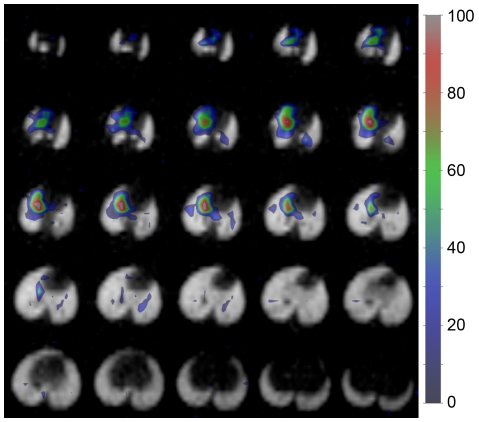
Dissolved 129Xe MR imaging.Axial, EC 129Xe infusion image (color; 2×2×2 mm3 nominal resolution; EC flow ∼15 ml/min) overlaid on the corresponding ventilation image (grayscale; 1×1×2 mm3 nominal resolution). High signal intensity is seen from the right heart and pulmonary arteries, but not from the lung parenchyma, due to RF attenuation and rapid diffusive losses of 129Xe from the capillary blood into the alveolar gas spaces. The signal intensity of the dissolved image (arbitrary units) is indicated in the legend.